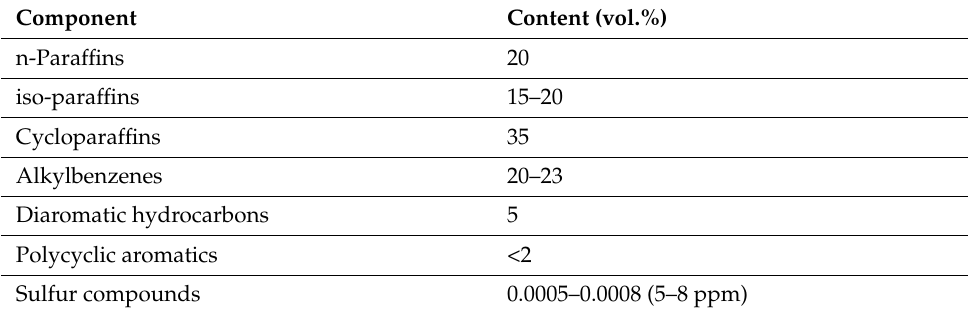
Table 1. A typical average composition of commercial diesel